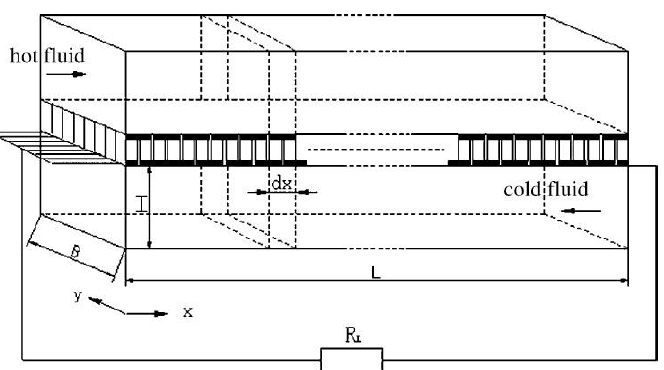
Figure 2. Numerical model of a flat plate finless heat exchanger MTEG. Reprinted with permission from ref. [18]. Copyright 2021 Elsevier and Copyright Clearance Center.